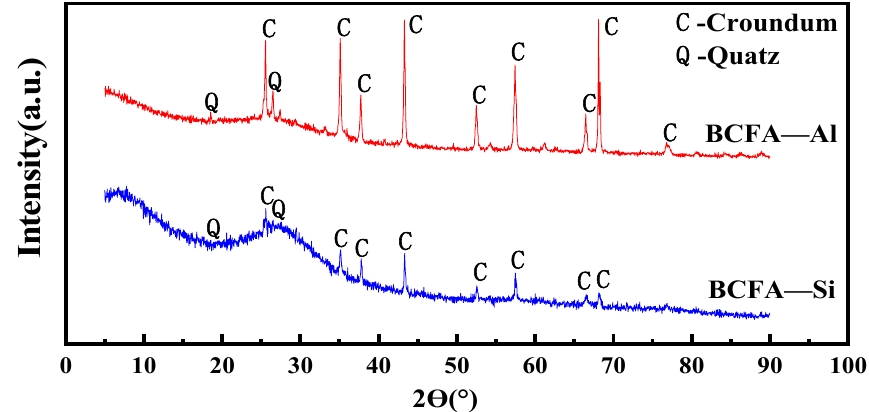
Figure 6. XRD analyses of BCFA after wet screening under 2800 meshes (BCFA-Al: wet screen residue, BCFA-Si: filter residue).